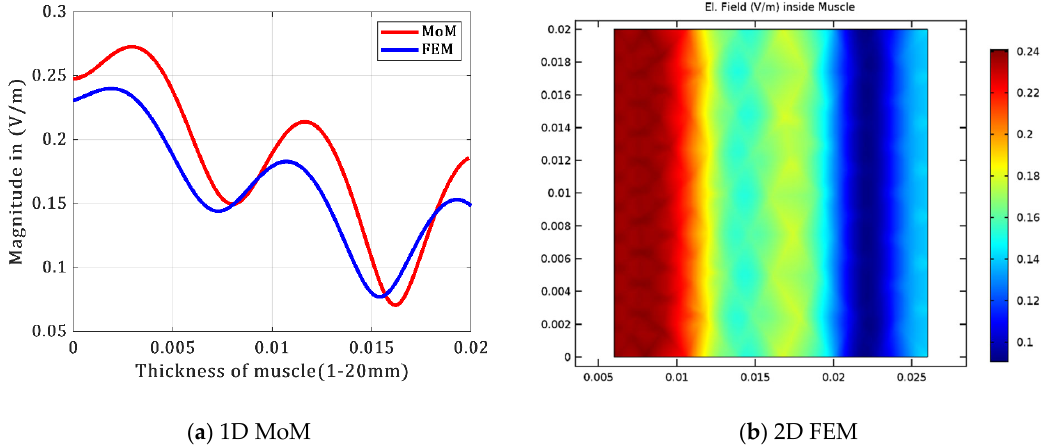
Figure 5. E ‐ field inside muscle tissue for both methods at 2.45 GHz.